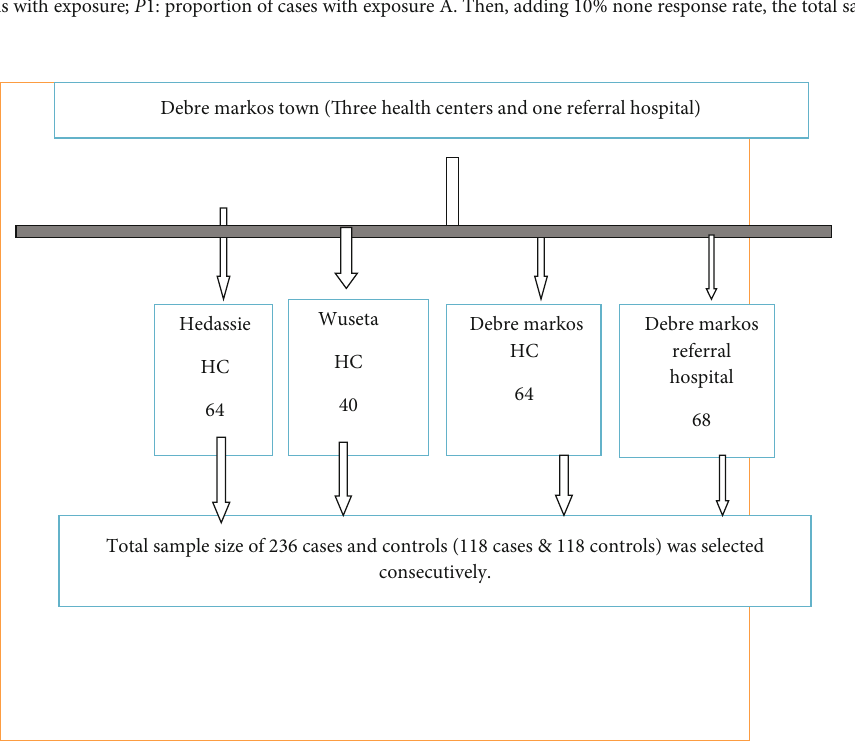
Figure 1: Schematic presentations of sampling process during the intensive phase in Debre Markos town public health facilities, North West Ethiopia,